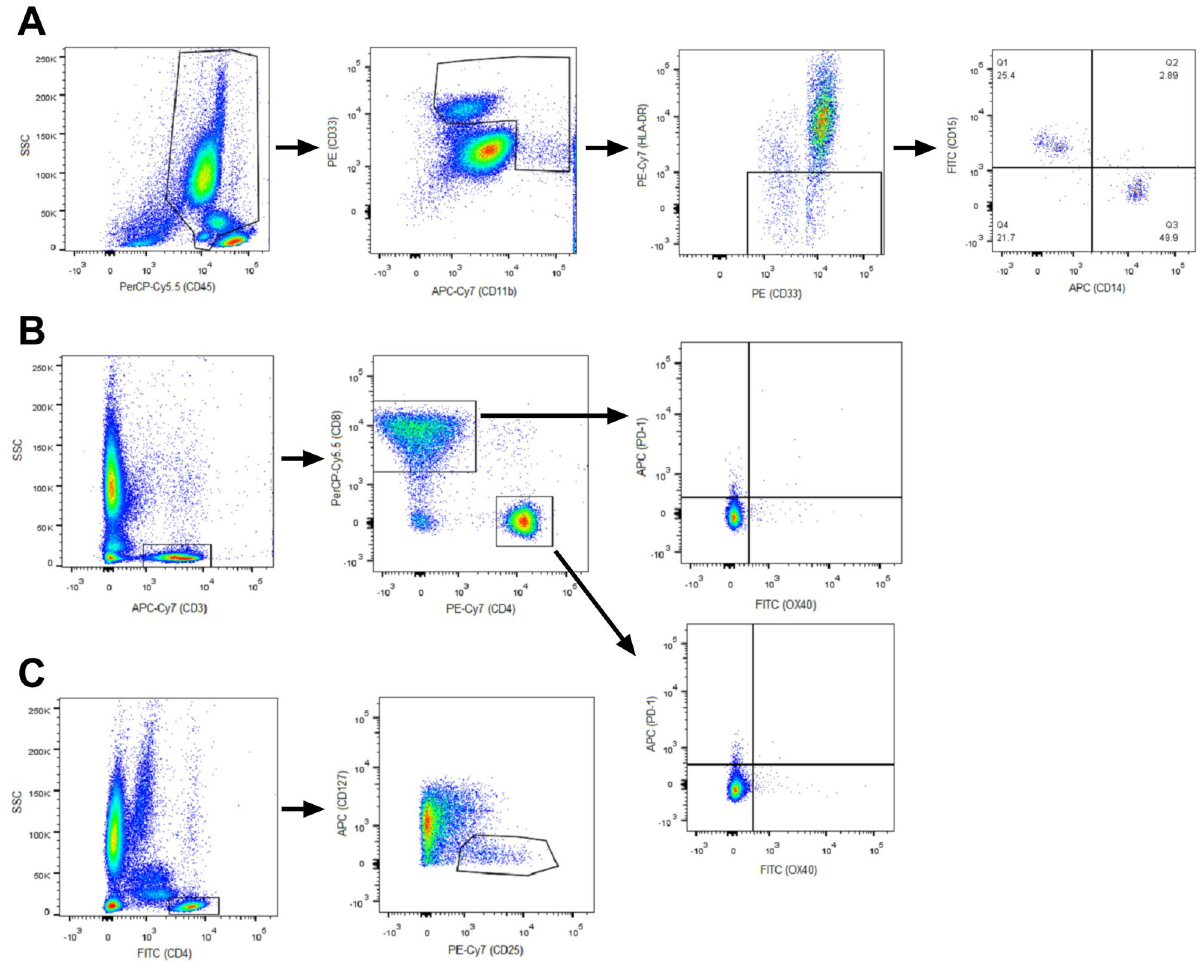
Figure 1. Gates of cell populations carried out by flow cytometry. M-MDSCs and G-MDSCs ( A ), CD4 + and CD8 + from OX40 + PD-1- and PD-1 + OX40- T cells ( B ), regulatory T cells ( C